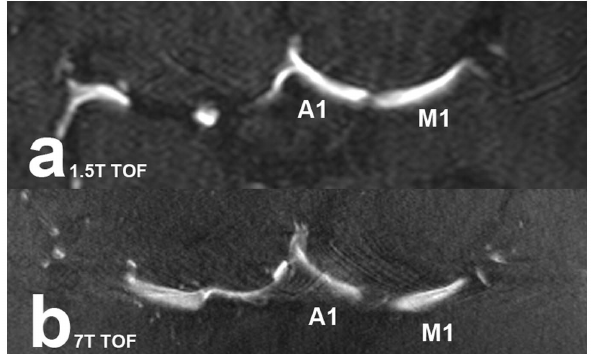
Figure 3. Pulsation artifacts near the carotid bifurcation in TOF MRA scans. The artifacts in 1.5 Tesla ( a ) and 7 Tesla ( b ) TOF MRA scans make vessel depiction more difficult (M1: middle cerebral artery (M1 segment); A1: anterior cerebral artery (A1 segment)).